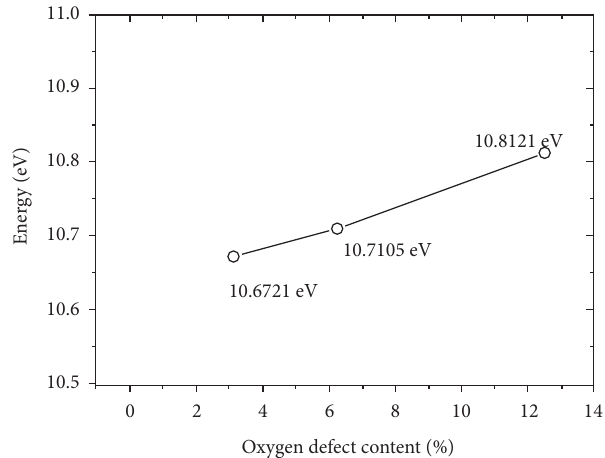
d for the 2 and oxygen-